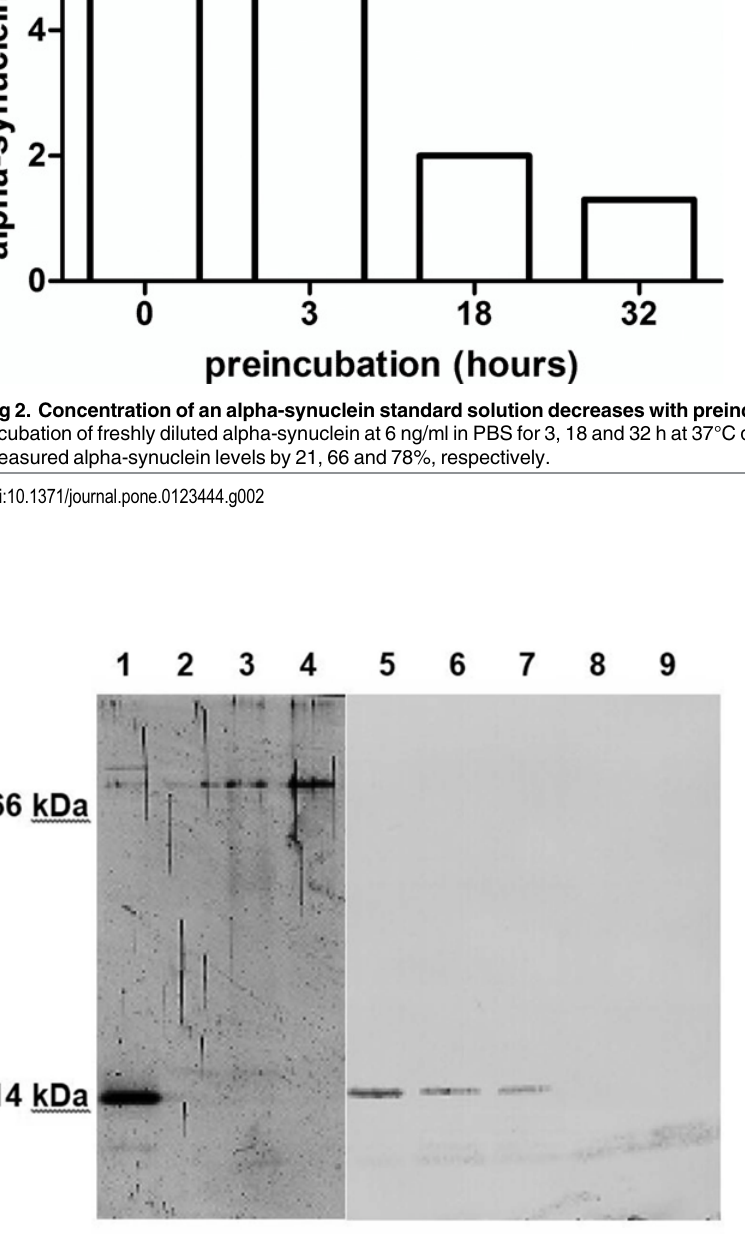
Fig 3. Western immunoblot of alpha-synuclein standard solution after preincubation. Lane 1 – 4 was probed with anti-alpha/beta/gamma-synuclein antibody (FL-140), lane 5 – 9 with anti-alpha/beta/gamma- synuclein antibody (syn211). Compared to freshly diluted alpha-synuclein in PBS at 6 ng/ml (0 h, lane 1 and lane 5), incubation at 37°C for 3, 18, 32 h (lane 2, 3, 4, respectively) resulted in fading of the monomeric alpha-synuclein band at 14 kDa and appearance of a higher molecular weight band using FL-140, whereas no higher molecular weight band was detected with syn211 after 1, 3, 5, 10 h (lane 6, 7, 8, 9, respectively).